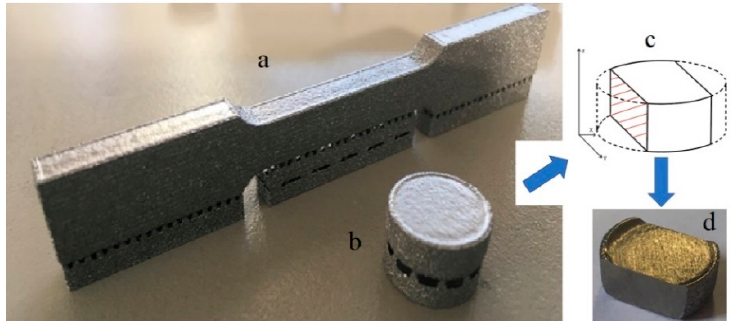
Figure 3. Build samples after shot peening: ( a ) as-build dog-shaped sample with supports, ( b ) as-build disk sample with supports; ( c ) schematic of cutting of disk sample to ensure two parallel and flat surfaces; ( d ) actual polished disk sample used for metallographic and macro-instrumented indentation test. Note that the flat cases are parallel to the build direction.